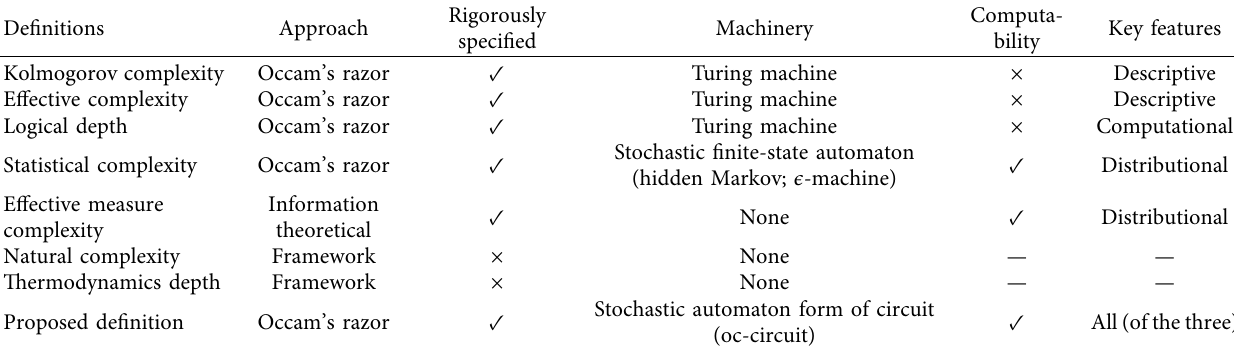
Table 2: Approach and machinery of the proposed definition and the existing